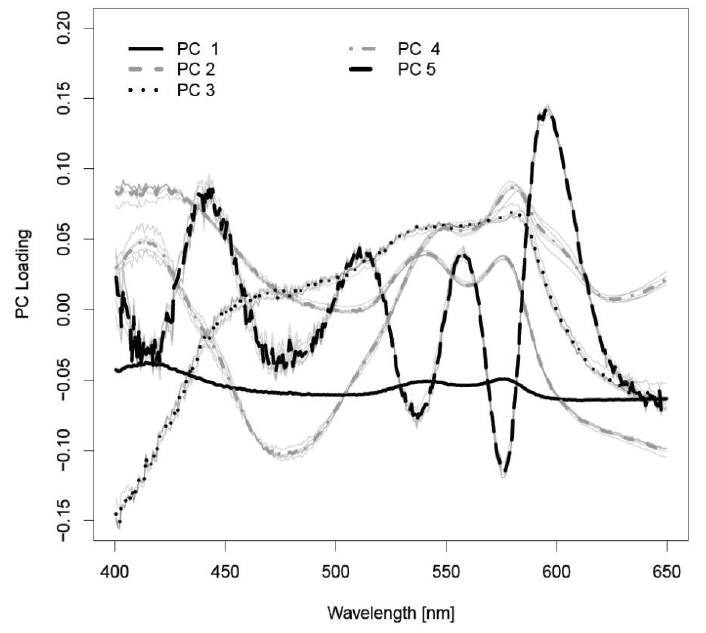
Figure 5. Loadings of the relevant principal